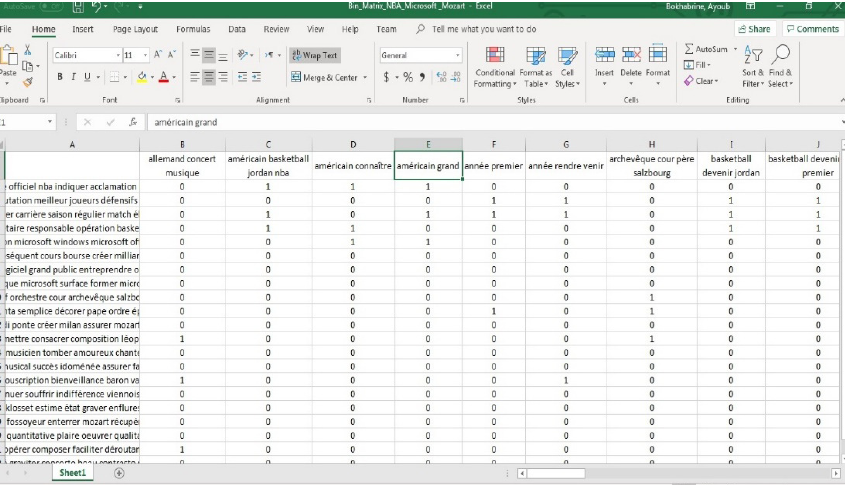
Fig. 5. Bit matrix of itemsets.